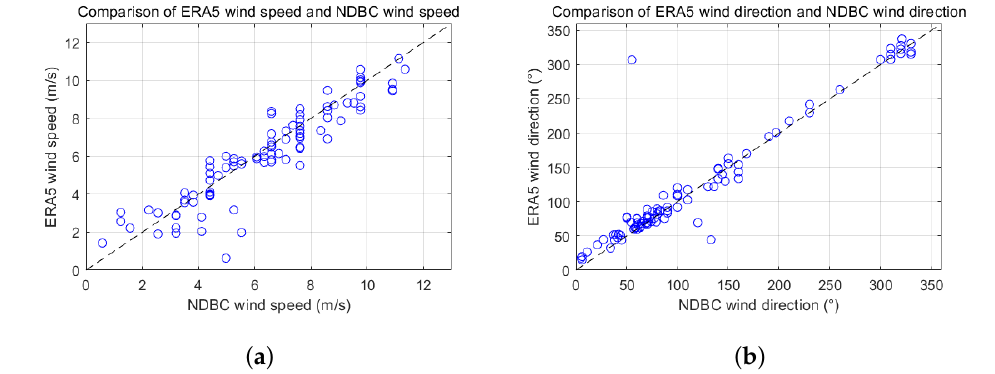
Figure 9. Comparison of NDBC buoy wind field and ERA5 wind field. ( a ) Wind speed comparison results; ( b ) wind direction comparison results.